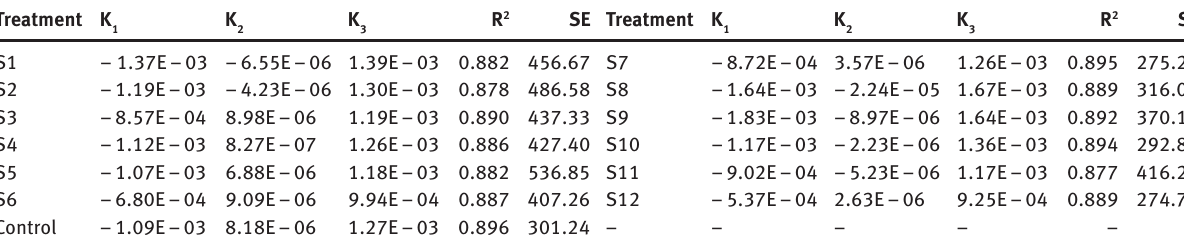
Table 9: Coefficients of the Gunary sorption isotherm, R 2 , and SE for the Cd sorptions of different treatments. Treatment K 1